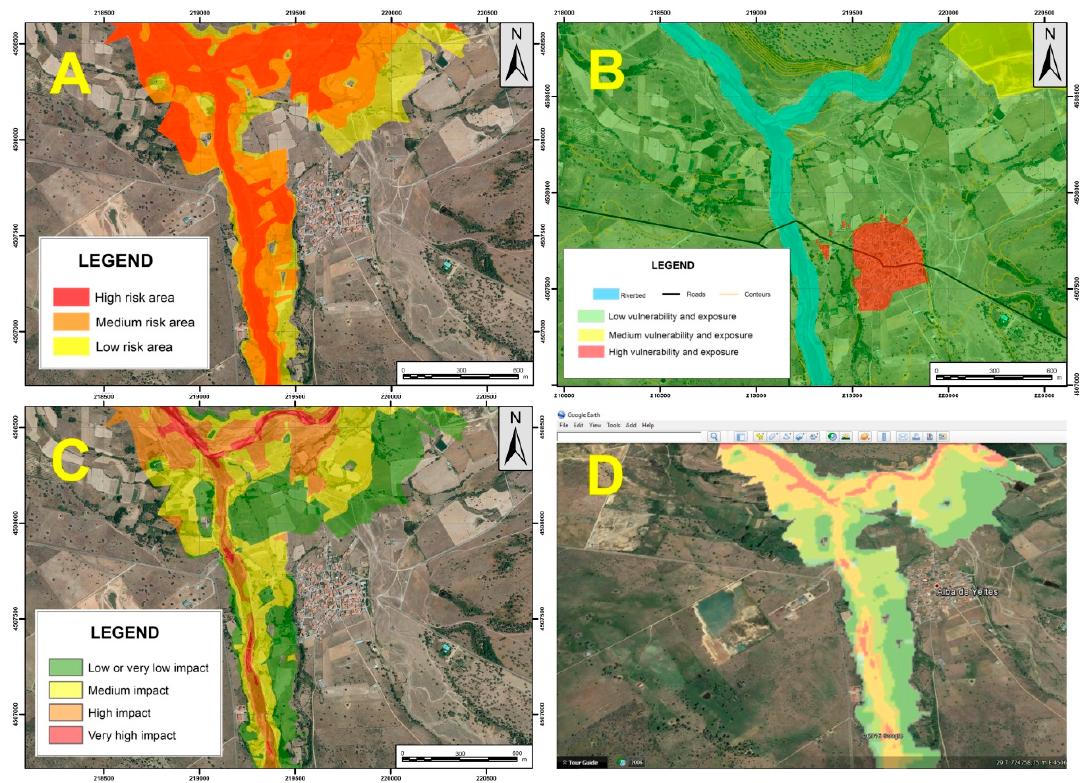
Figure 10. ( A ) Risk map; vulnerability and ( B ) exposure map; ( C ) environmental diagnostic map of flood risk and ( D ) the view of the environmental diagnostic map using Google Earth.